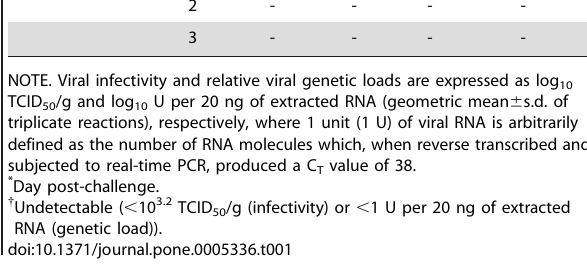
Figure 3. Intranasal vaccination with c 2 Flu ( c 2 A/PR8[H1N1]) protects against H5N1 challenge. Groups of 10 BALB/c mice were either mock treated (A) or vaccinated with c 2 A/PR8 (B). Mice were challenged 4 weeks later with 3 MID 50 of A/Vietnam/1203/2004[H5N1] intranasally and weight recorded daily for 21 days. doi:10.1371/journal.pone.0005336.g003 post-challenge (Table 1). The detection of viral infectivity and viral RNA in the lung of 1 vaccinated mouse on day 3 post-challenge but not on day 6 indicates that the observed cross-protective immunity is most likely mediated by memory Tc cells, which express accelerated activation kinetics over that of naı¨ve Tc cells [14]. We also have preliminary data showing that passive transfer of CD8 + T cells, but not serum, from mice vaccinated 6 days previously with c -Flu can confer protection against lethal heterotypic infection (Furuya et al, in preparation).